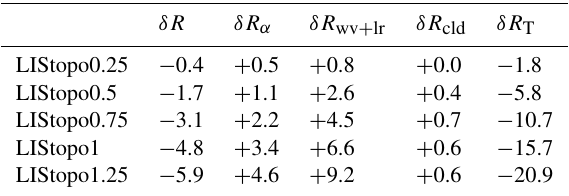
Table 2. Changes in TOA net radiation (Wm − 2 ) with respect to LIStopo0 ( δR ), and estimated contributions to δR from changes in surface albedo ( δR α ), water vapor and lapse rate ( δR wv + lr ), cloudi- ness ( δR cld ), and surface temperature (Planck feedback; δR T